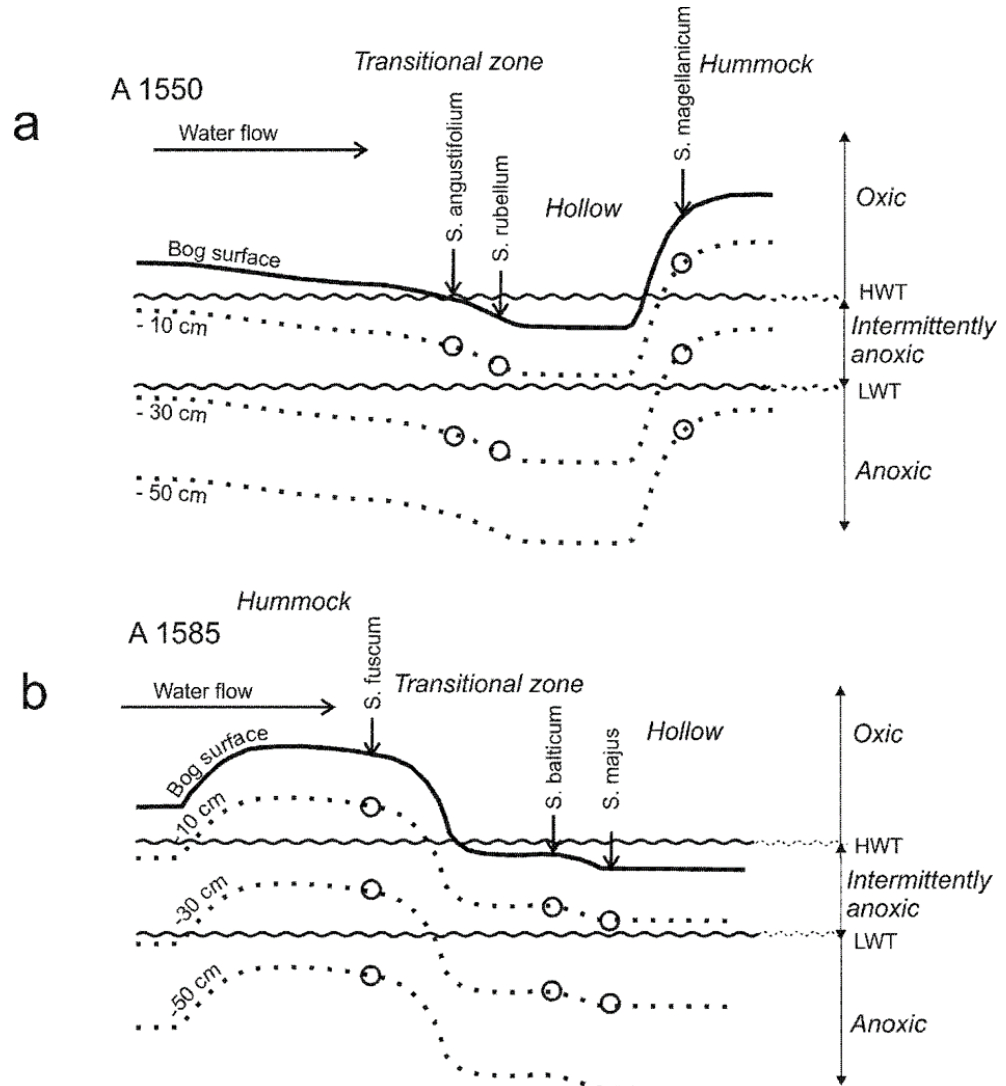
Figure 3. Locations of the litter bags in hummock ( S. fuscum, S. magellanicum ), hollow ( S. majus ) and lawn ( S. balticum, S. angustifolium, S. rubellum ) habitats in relation to depth, degree of oxygenation and water table fluctuation (HWT = highest water table, LWT = lowest water table). In a) (Site A 1550) the litter bags were buried on the ‘upstream’ side of a hummock, i.e . on the side facing into the surface water flow; in b) (Site A 1585) they were placed on the ‘downstream’ side of a